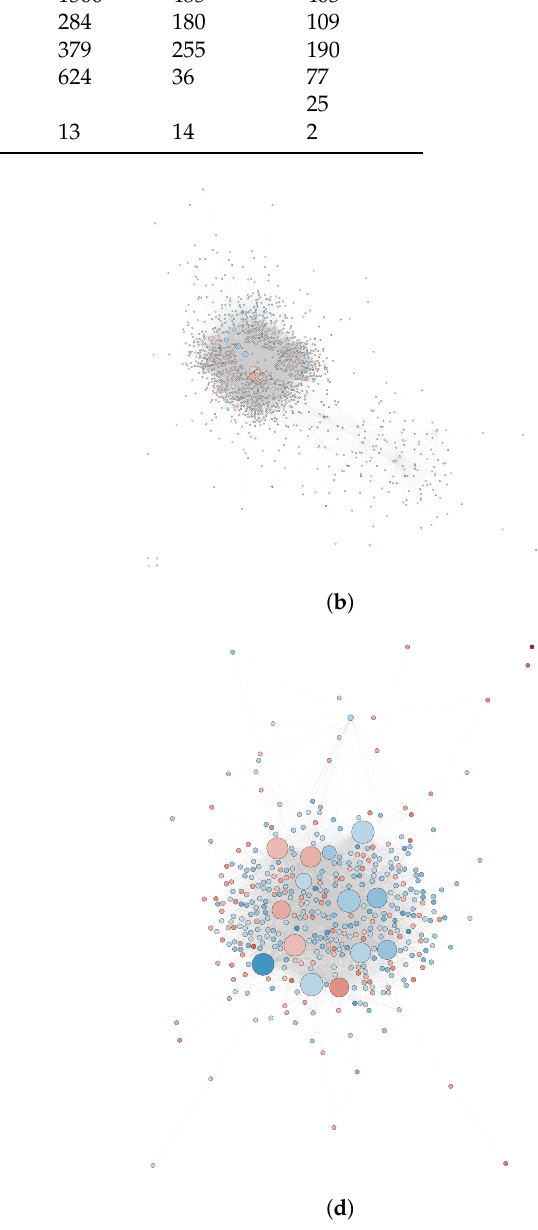
Figure A5. Inferred networks for ( a ) liver wt (1118 nodes, 16,281 edges, 4 clusters), ( b ) liver ko (1300 nodes, 15,727 edges, 3 clusters), ( c ) spleen wt (485 nodes, 4042 edges, 3 clusters), ( d ) spleen ko (403 nodes, 4220 edges, 4 clusters). Nodes are colored according to log2FC, upregulated genes in blue, downregulated genes in red. Clusters are numbered from left to right. Node size is represented according to node’s degree. Edge transparency is represented according to edge weight. Networks are displayed using the yfiles organic layout